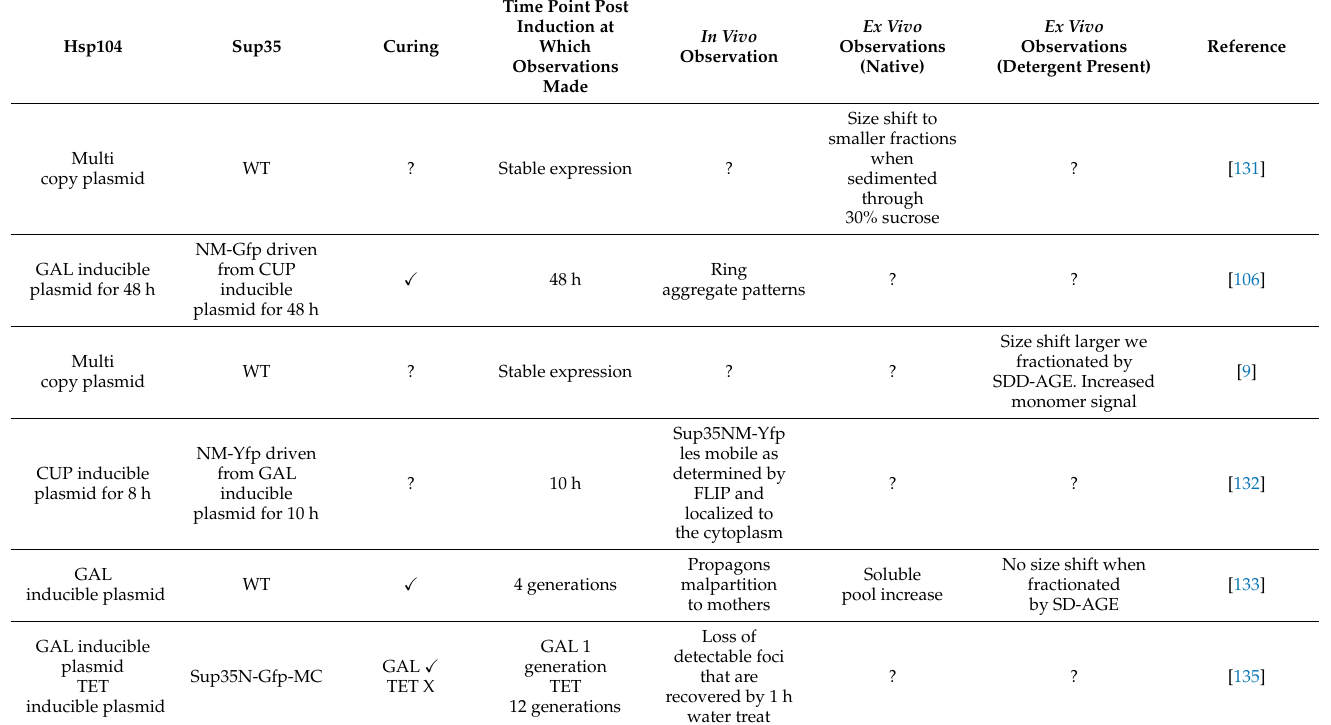
Table 2. Comparison of Hsp104 overexpression studies and observations. Use of ? denotes where the indicated properties were not measured. (cid:88) denotes property was observed. X denotes property was not